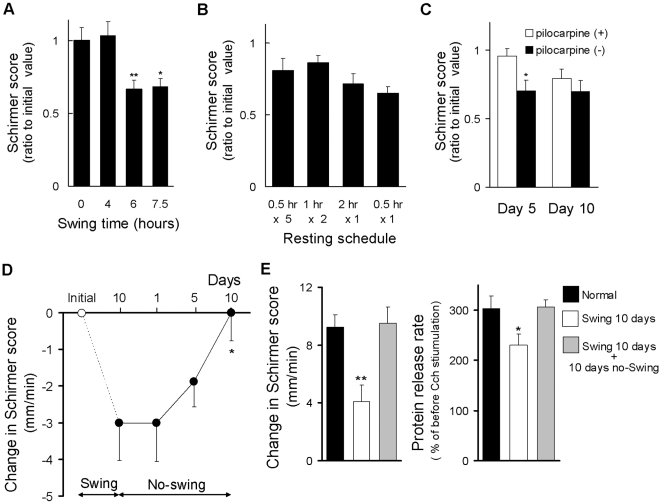
Recovery of tear secretion with long-term rest without swing activity.(A) Effect of shortening the time spent on the swing. Ratios to initial value were calculated. Data represent the mean ± SEM for 16 eyes. * P<0.05, ** P<0.01 versus 0 hour riding swing group. (B) Effects of changing resting patterns in tear secretion. Ratios to initial value were calculated. Data represent the mean ± SEM for 16 eyes. (C) Effect of stimulation on the lacrimal function for the two groups, with and without pilocarpine injection. Ratios to initial values were calculated. Data represent the mean ± SEM for 16 eyes. (D) Effect of extended rest period without the swing. Data represent the mean ± SEM for 8 to 16 eyes. * P<0.05 versus day 10. (E) Effect of extended rest period without the swing on tear secretion in response to parasympathetic stimulation (Left) and recovery of protein released from isolated LG (Right). Data represent the mean ± SEM for 8 to 16 eyes. * P<0.05 versus the normal.